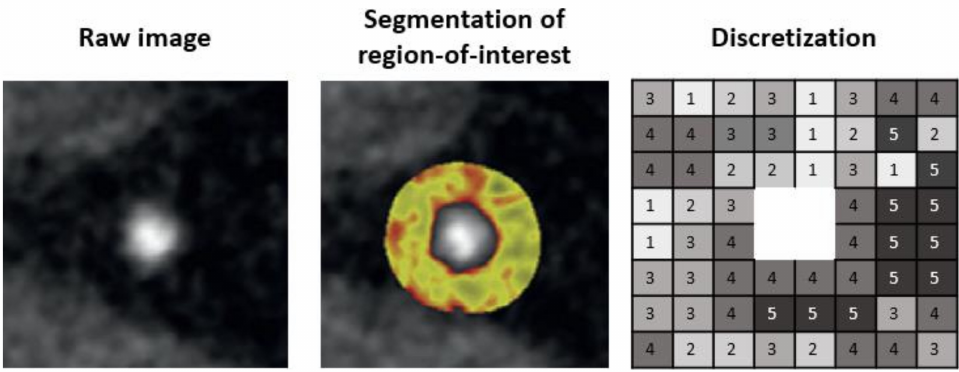
Figure 1. Pipeline for segmentation of region-of-interest.